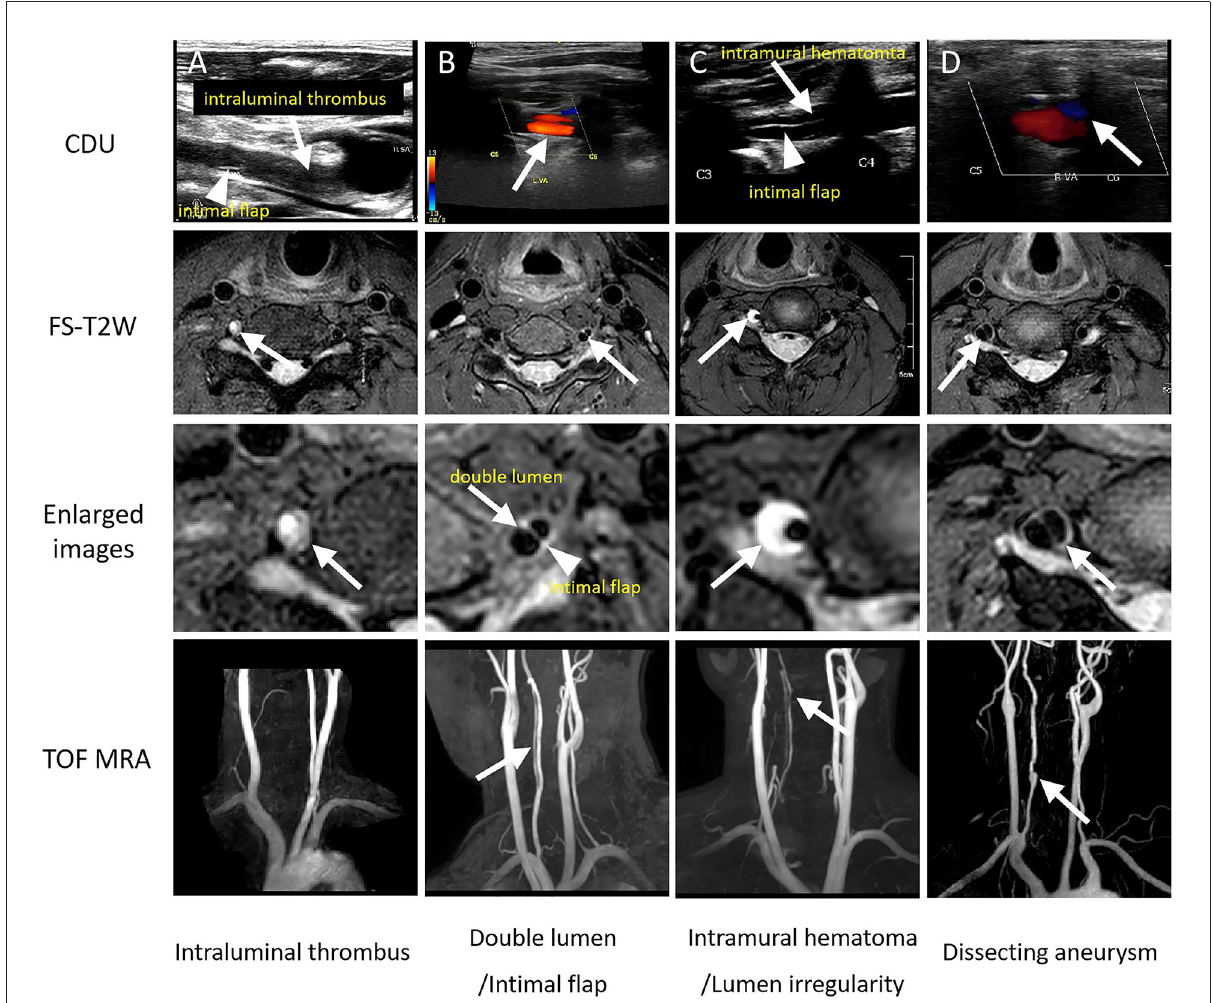
FIGURE1 Characteristics of the extracranial vertebral artery dissection on color duplex ultrasonography (CDU) and its corresponding, pathognomonic high-resolution magnetic resonance imaging signs. The (A–D) four columns represent four patients (Patients # 1, 2, 3, and 4), respectively, and each column from top to bottom is CDU, fat-suppressed T2-weighted (FS-T2W), magnified view of FS-T2W, and 3D time-of-flight magnetic resonance angiography (TOF)